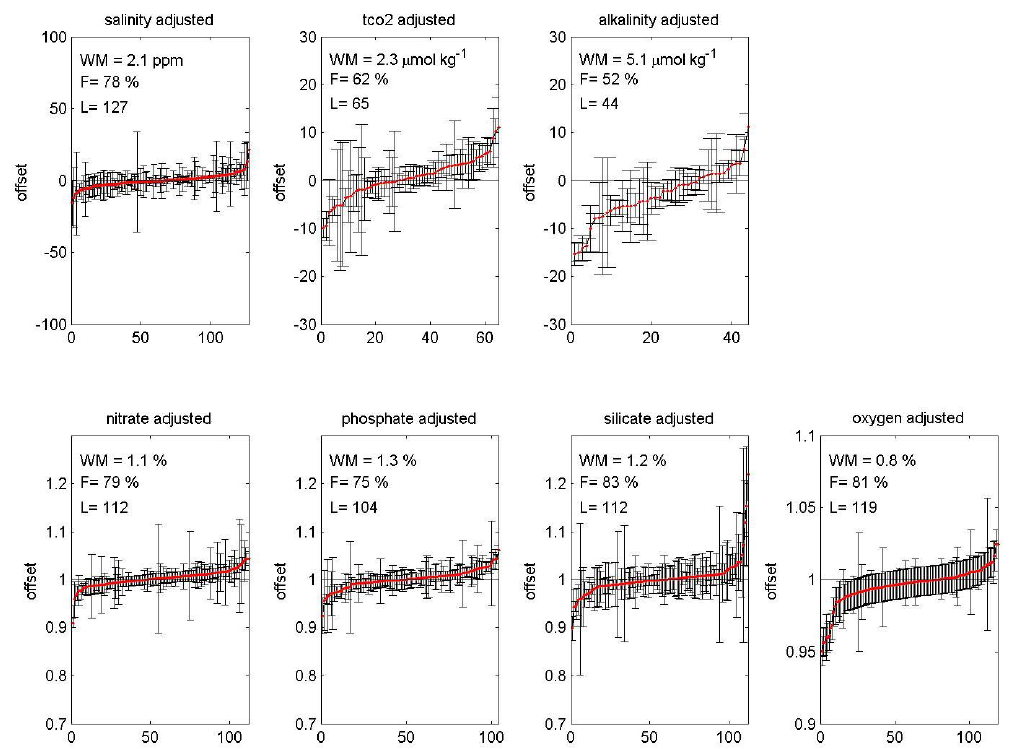
Figure 4. O ff sets calculated for the crossovers in the merged CARINA-GLODAP Southern Ocean dataset after adjustments have been applied (Table 2). WM is the weighted mean calculated for each parameter using the absolute value of the o ff set ( D ) of all crossovers ( L ) with the uncertainty σ (error bar), according to Eq. (2). F is the percentage of o ff sets indistinguishable from 1 (multiplicative) or 0 (additive) within their uncertainty and L is the number of